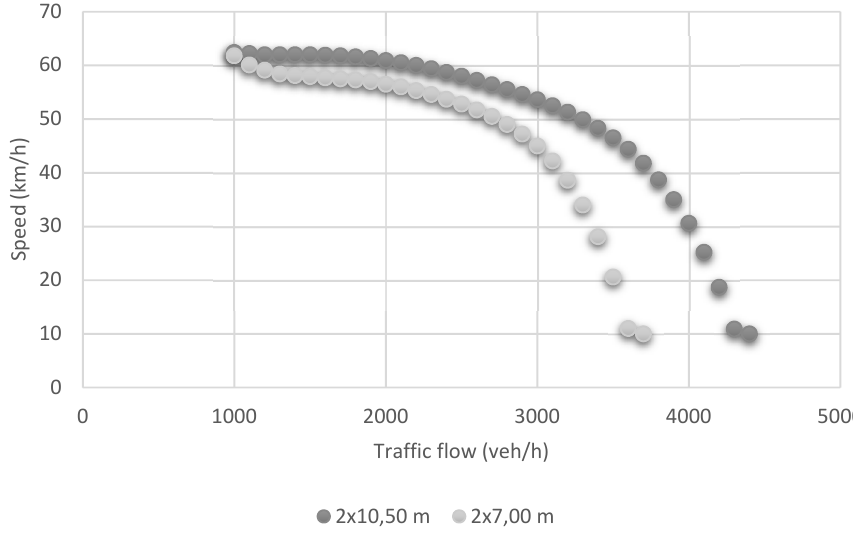
Figure 4. Speed-traffic flow curves for urban double carriageways. Source: Adapted from “Instruc- tion for assessing the economic efficiency of road and bridge projects 2008”.